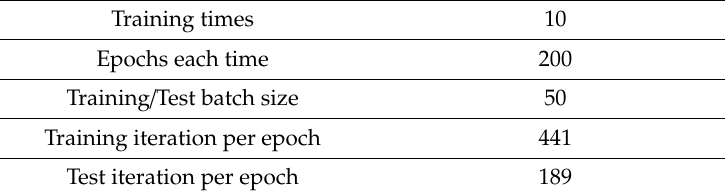
Table 2. Parameter values used in the training model.